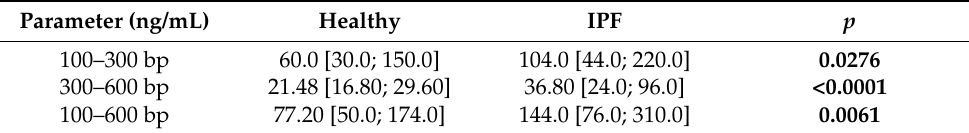
Table 2. Plasma concentrations of different size ccfDNA in healthy and IPF patients.